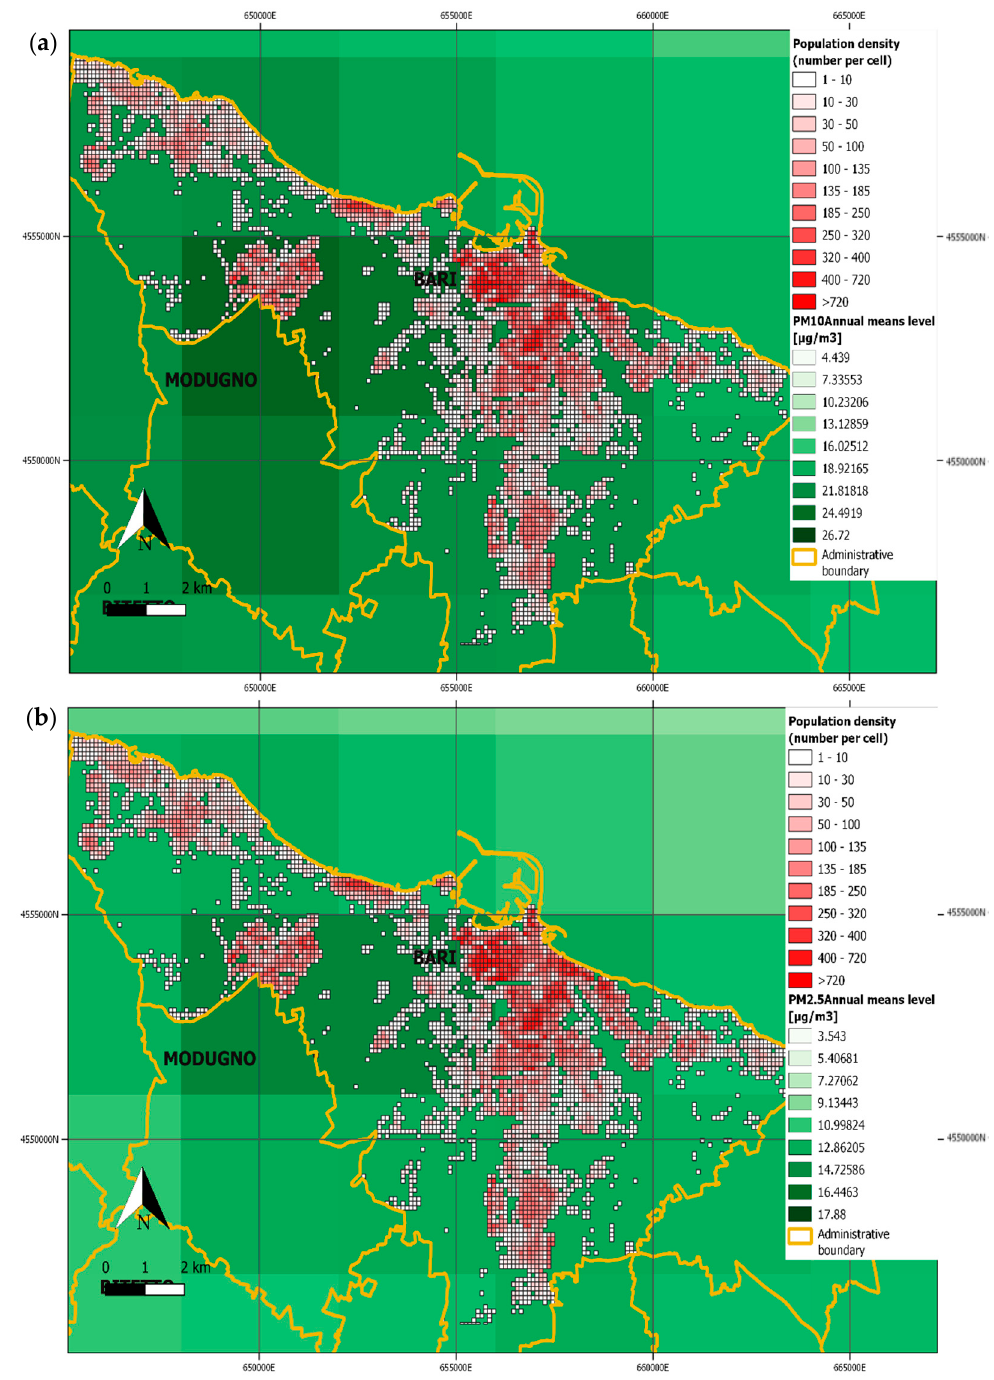
Figure 27. SDG 11.6.2 Indicator: Annual mean levels of fine particulate matter weighted to total population of Bar city: ( a ) PM 10 and ( b ) PM 2.5.